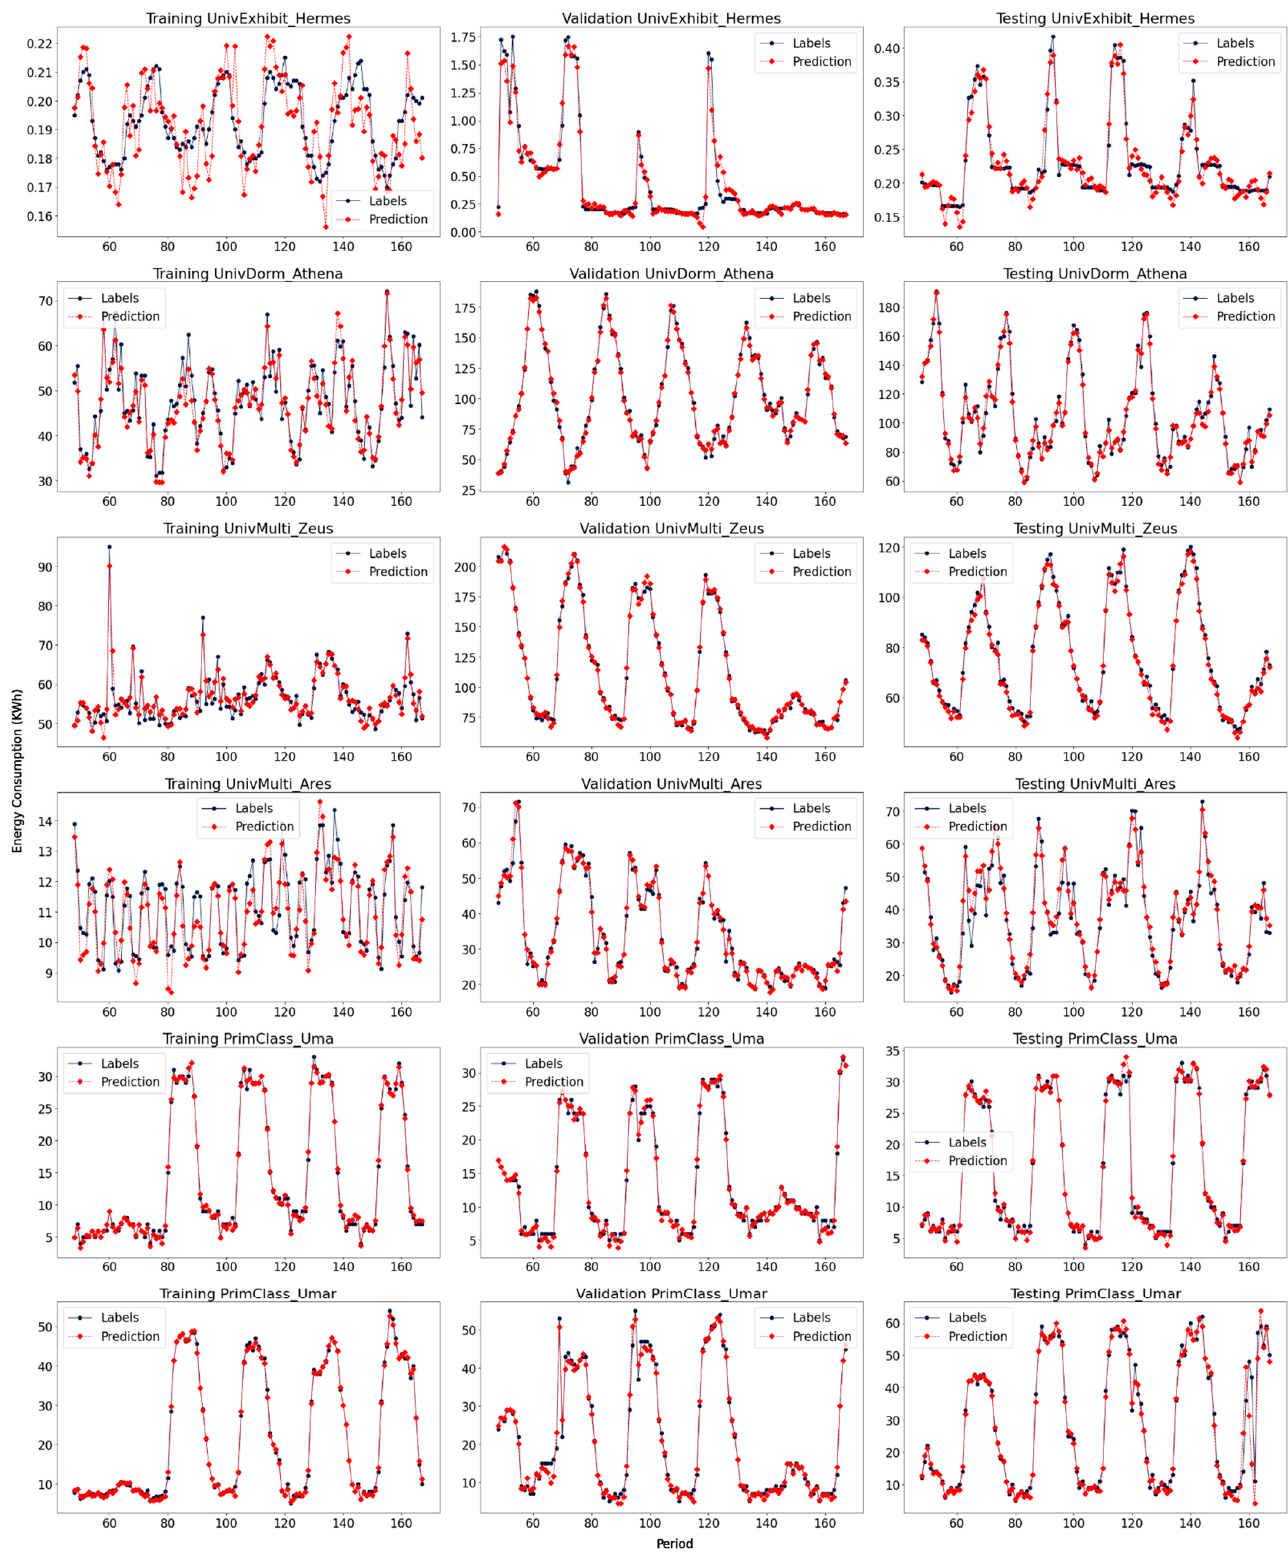
Figure 7. Comparison of the Actual and Predicted Value. Furthermore, this study also applies a time-series cross-validation to evaluate the forecasting result. Figure 8 shows the framework of the time-series cross-validation